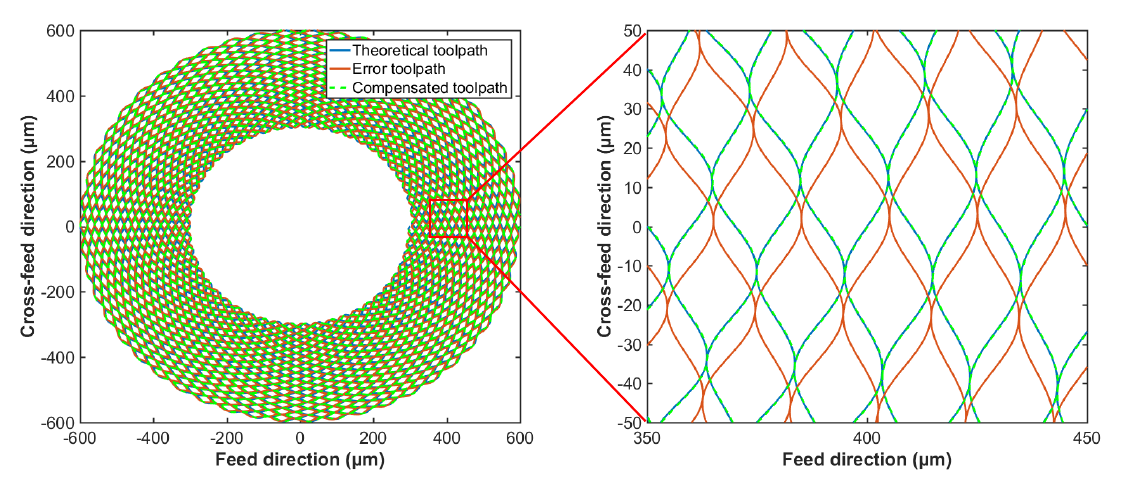
Figure 6. The effects of compensation on the